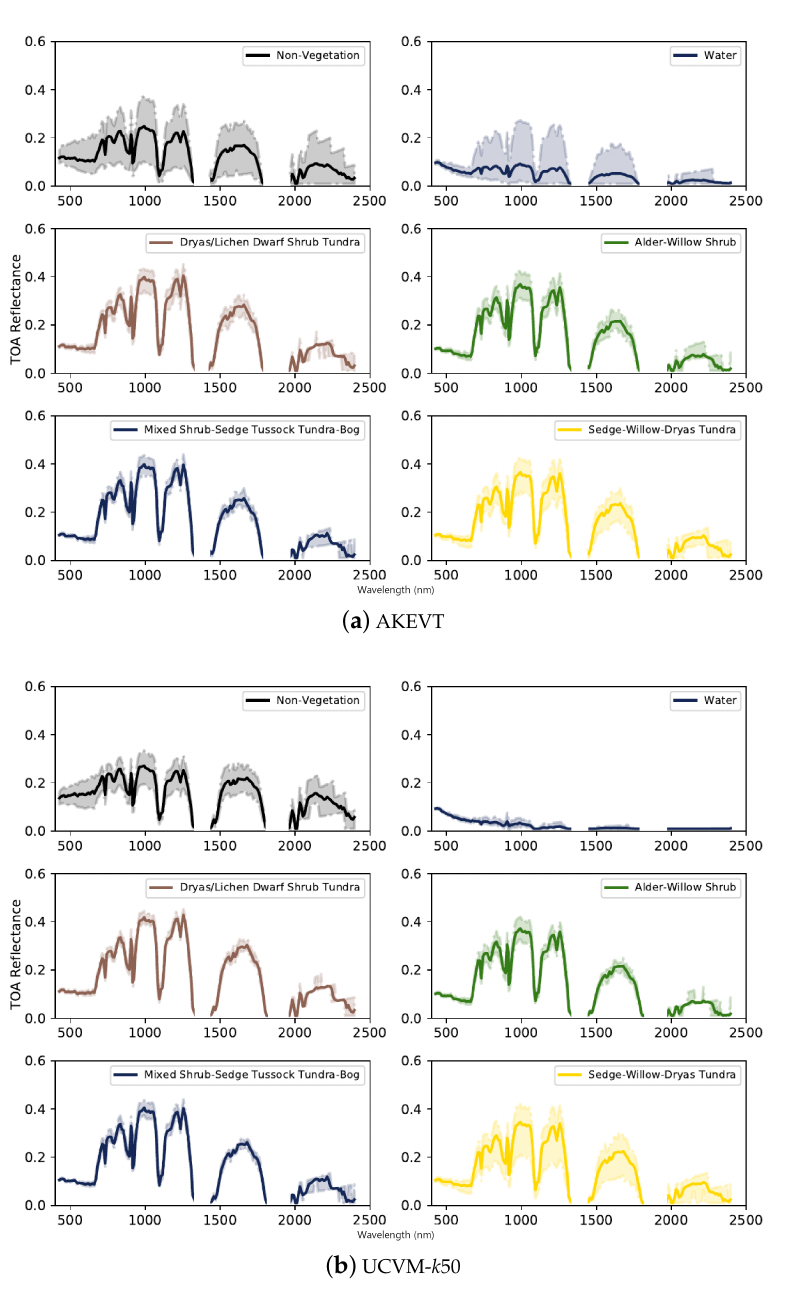
Figure 7. Spectral characteristics of the EO-1 Hyperion dataset (400–2500 nm) for each vegetation class from the for the AKEVT ( a ) and UCVM ( b ) maps, showing spectral differences described in Section 4.2. Solid lines and shaded curves show the mean and 90th percentile distribution of values across the classes respectively. The masked out regions consists of the non-calibrated